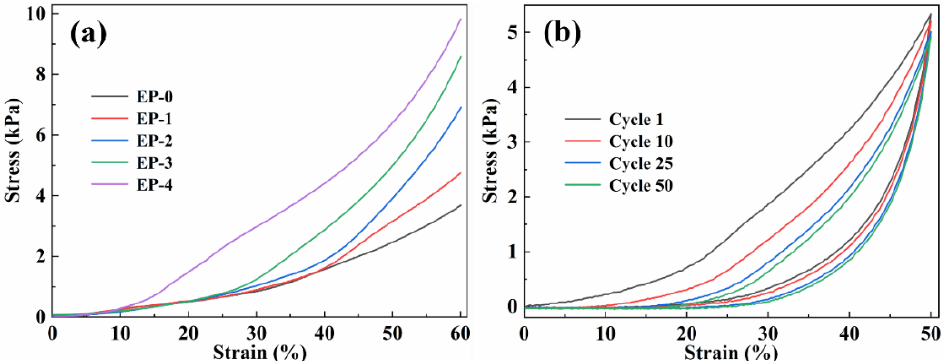
Figure 4. ( a ) Compressive stress–strain curves (ε = 60%) of EVOH/PANI composite NFAs with